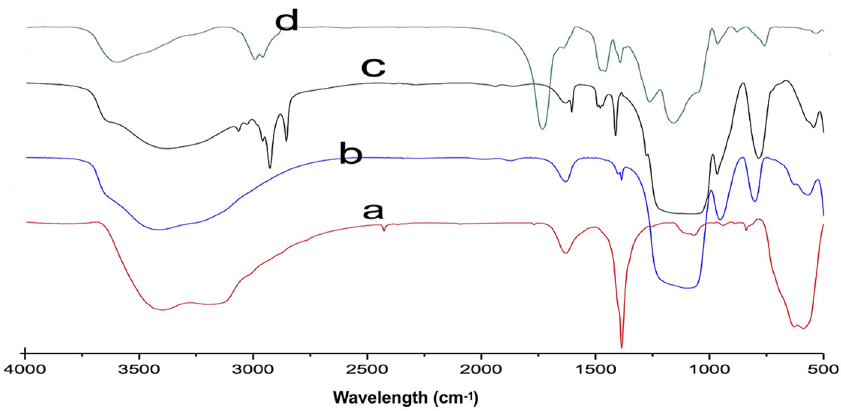
Figure 2. Fourier transform infrared (FT-IR) spectra of Fe 3 O 4 ( a ), Fe 3 O 4 @SiO 2 ( b ), vinyl modified Fe 3 O 4 @SiO 2 ( c ) and MIIP ( d ).